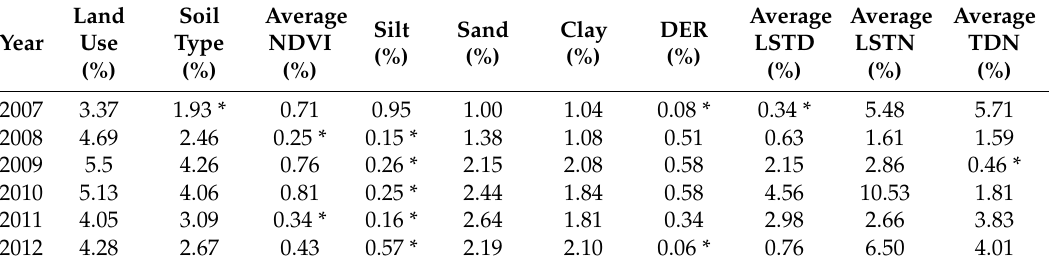
Table 3. Results of factor detector